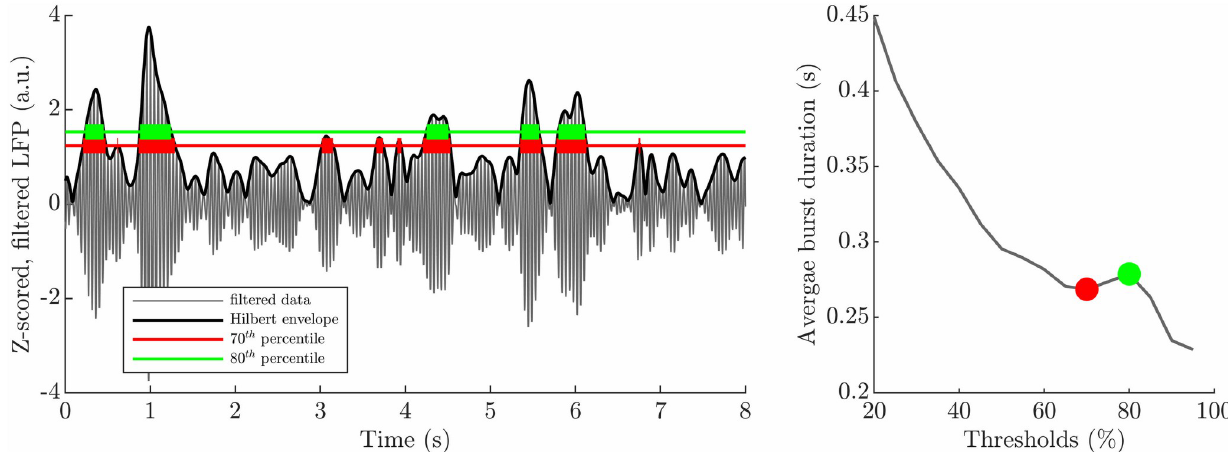
Fig 2. Average burst duration profiles can have complex shapes. Thick lines highlight the duration of individual bursts for two thresholds in the left panel. The corresponding averages are identified with the same colour in the average burst duration profile in the right panel. Longer bursts are still present at the 80 th percentile, and shorter bursts are significantly more frequent at the 70 th percentile than at the 80 th percentile. In addition, high amplitude, longer bursts are sharp (quick rise and fall), and therefore their duration is only shortened slightly from the 70 th to the 80 th percentile. As a result, the average burst duration profile is